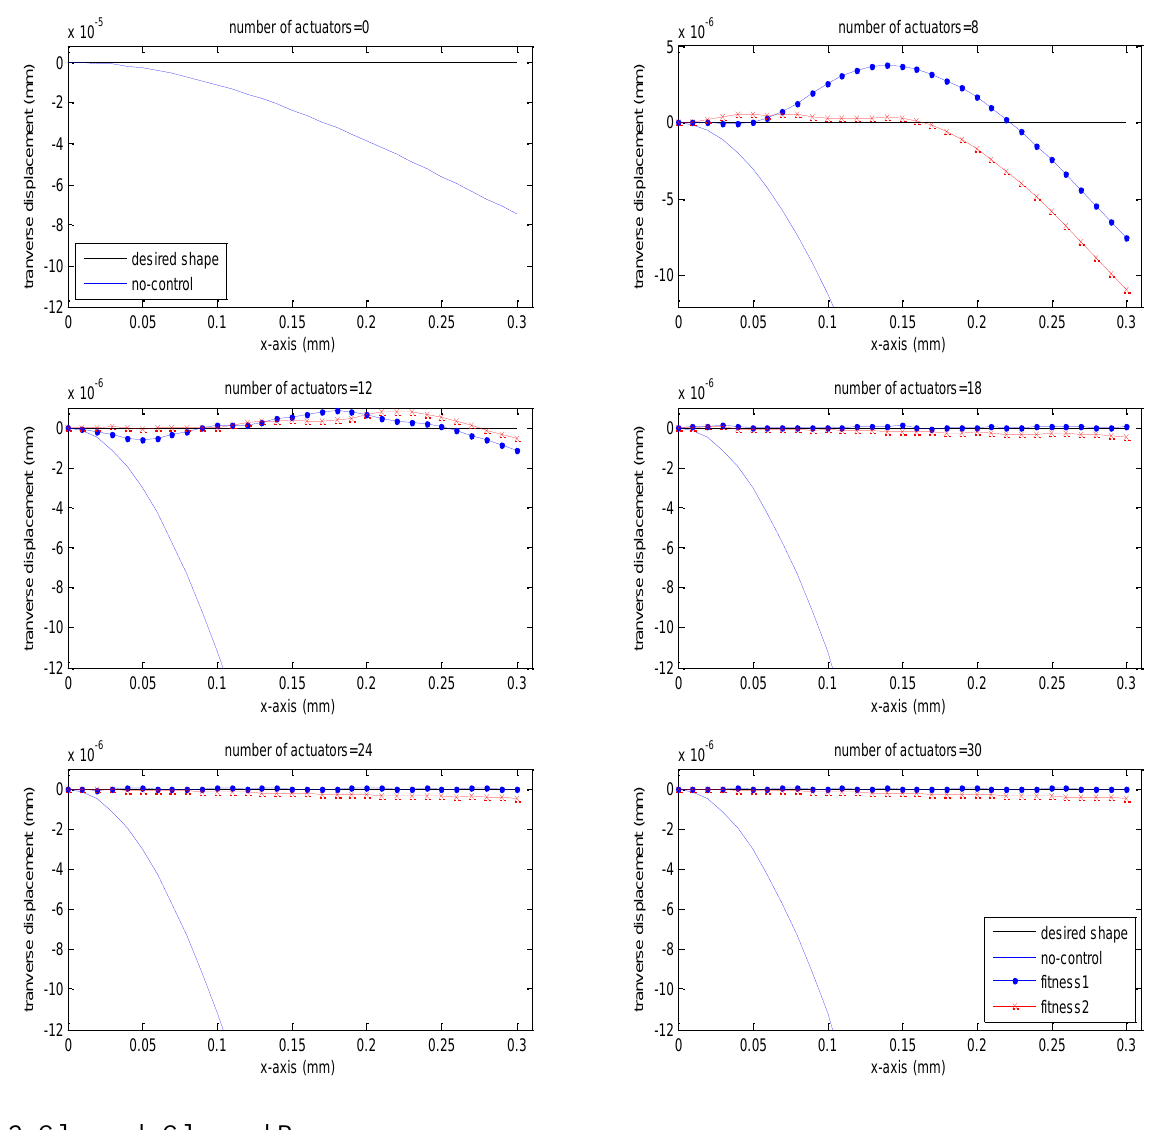
Figure 3. The centerline of the cantilever smart beam under the action of various numbers of actuators for X d (x) = 0 with the optimal location of the actuators and the optimal values of actuation